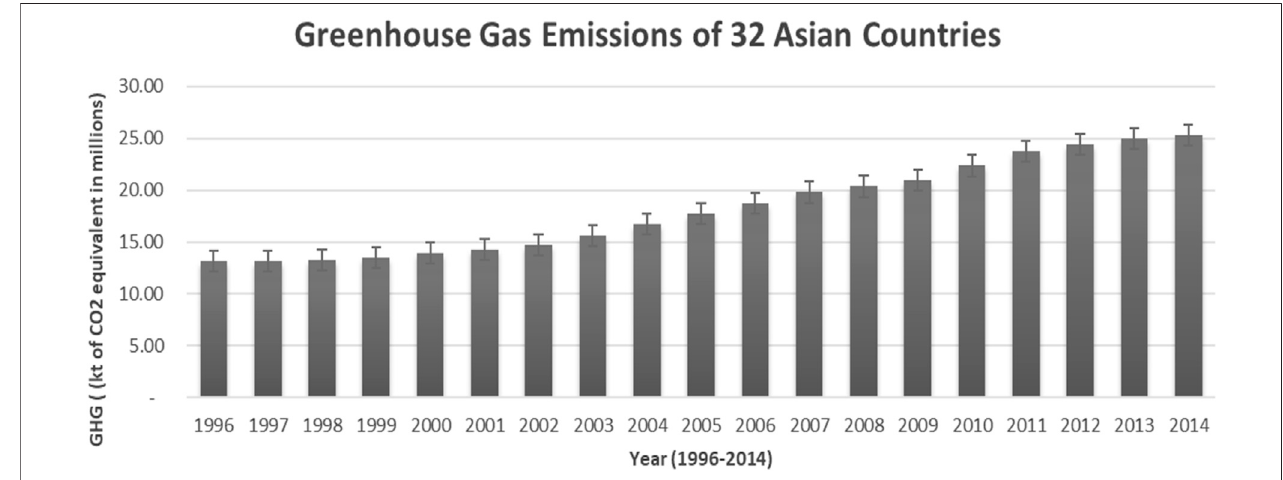
FIGURE 1 | Annual total GHG